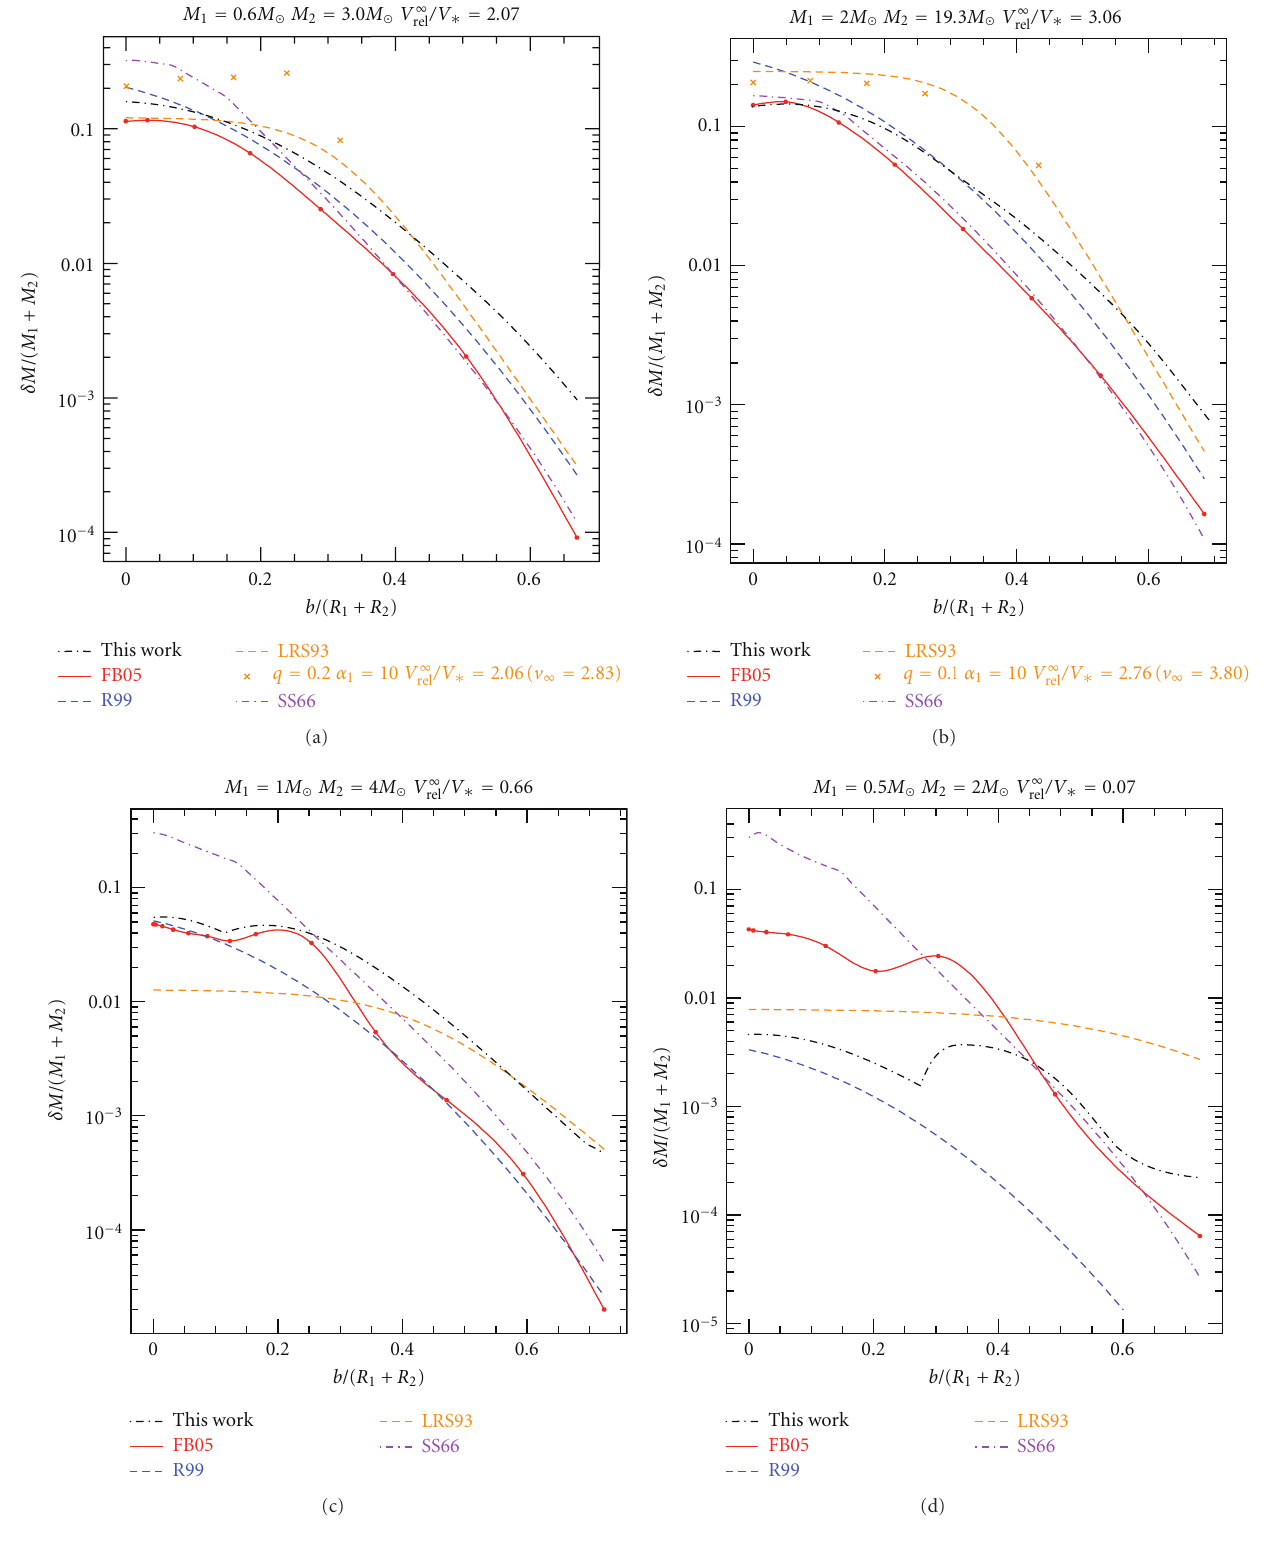
Figure 6: The calculated fractional amount of mass lost as a function of impact parameter from several works. Our results are the black dashed-dotted lines. The figures are adopted from Freitag and Benz